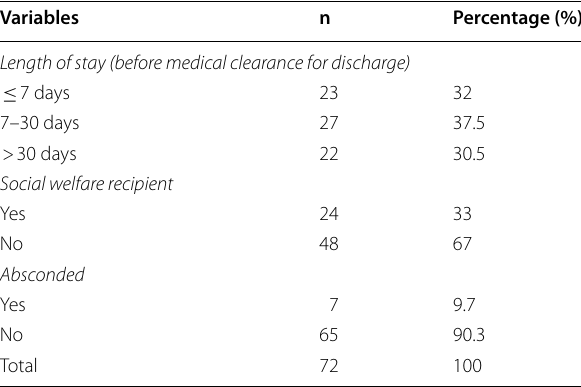
Table 3 Patient hospitalization